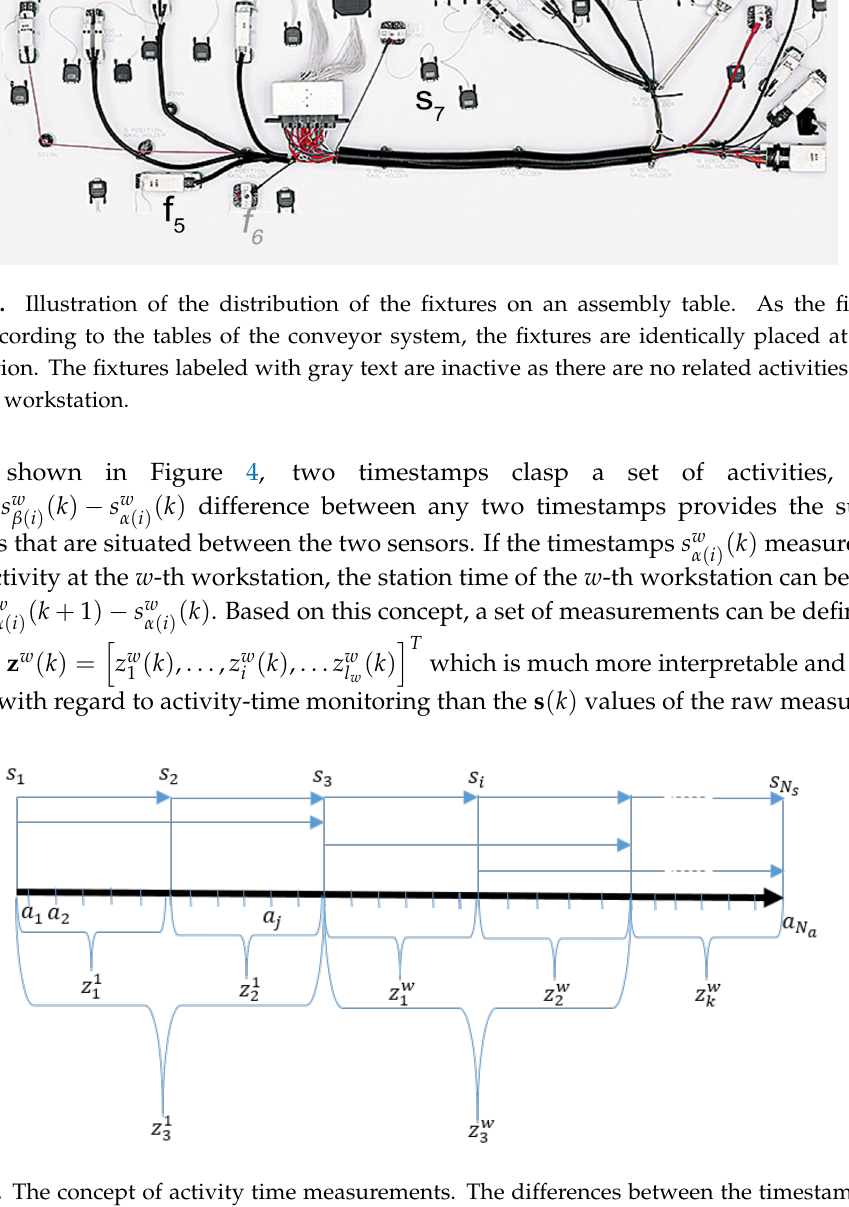
Figure 4. The concept of activity time measurements. The differences between the timestamps ( s i ) define the time period required by a set of activities ( a j ), the totals of which are considered as measured variables at each workstation ( z w ), where w represents the index of the i